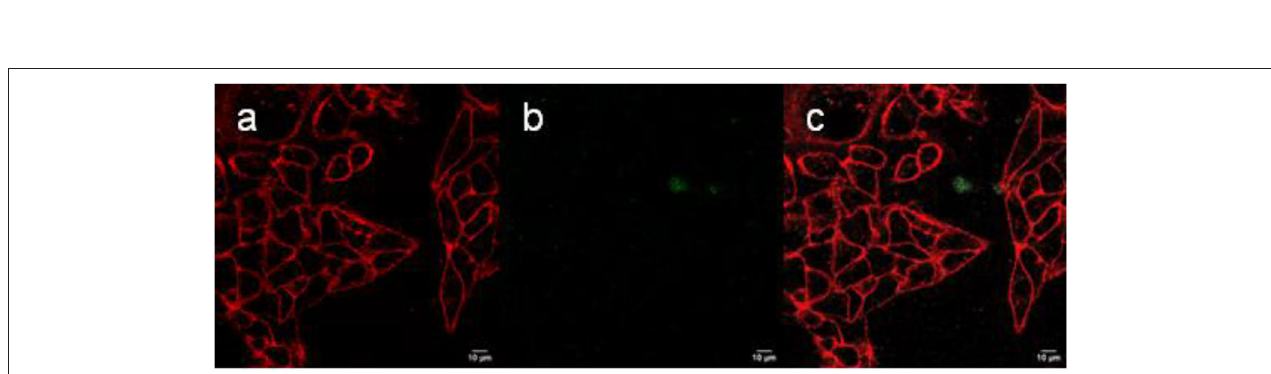
FIGURE 9 | (a–c) Confocal micrographs showing the distribution of NaYF 4 :Yb 3 + /Er 3 + @NaYF 4 :Nd 3 + -PEG 5,475 -Alk nanoparticles in Hep-G2 cells at 980nm excitation with a laser power of 30–50 mW. (a) CellMask TM deep red cell-stained cell membrane, (b) nanoparticles, and (c) overlay of (a,b) .